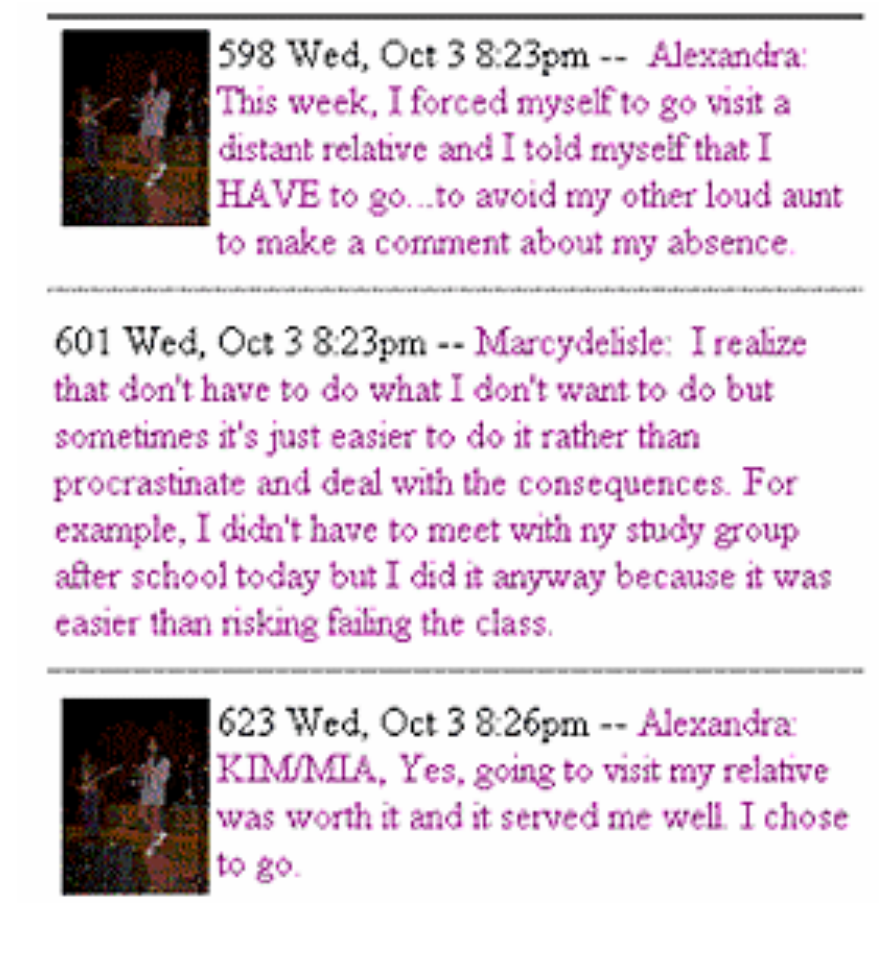
Figure 17. Examples of reporting back to the